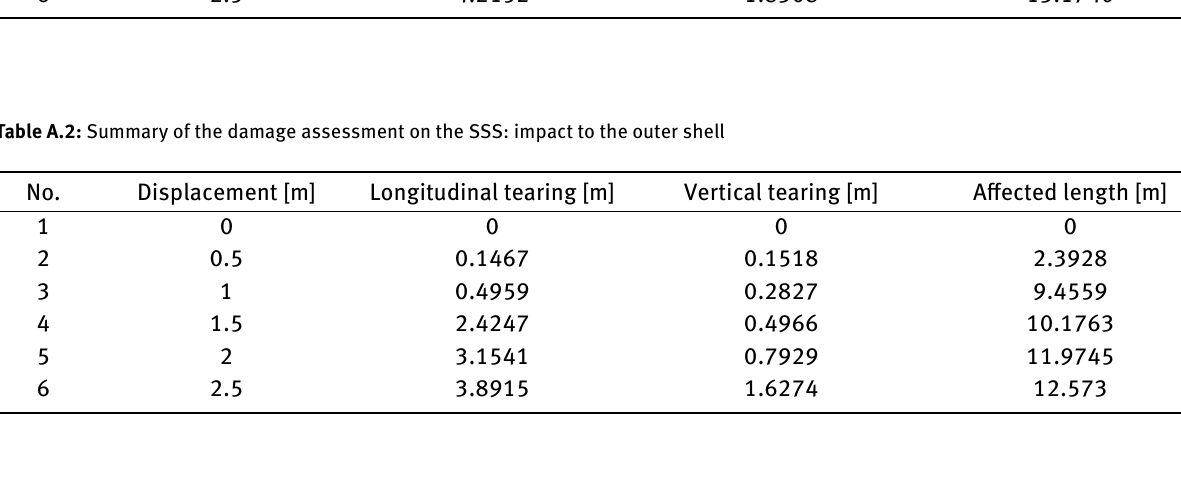
Table A.3: Summary of the damage assessment on the DSS: impact to the upper deck No.